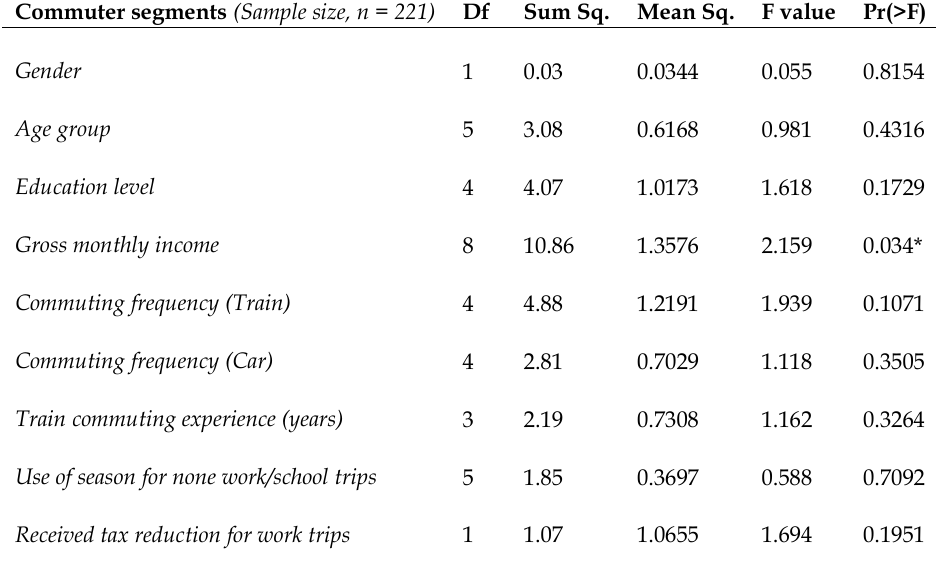
ANOVA results. Significance codes: ‘*’